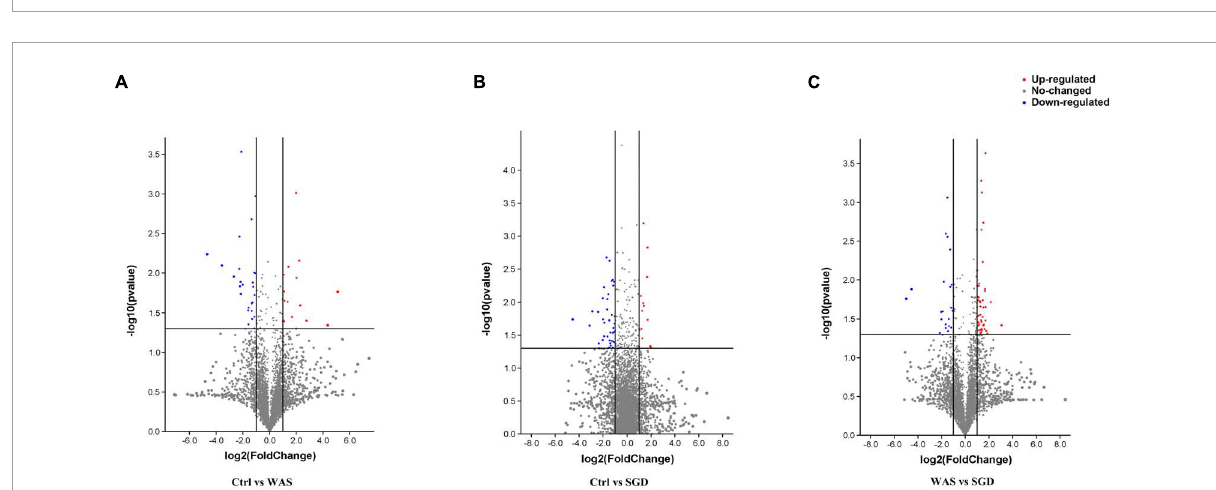
FIGURE7 Metabolic profiling: volcano plot. (A) 26 metabolites (red dots) were significantly up-regulated in the feces of the WAS group compared with the control group; (B) 14 metabolites (red dots) were significantly up-regulated in the feces of the SGD group compared with the control group; (C) 44 metabolites (red dots) were significantly up-regulated in the feces of the SGD group compared with the WAS group. The red dots in the figure indicate FC > 2.0 and P < 0.05. The differential metabolites were screened by univariate statistical analysis.